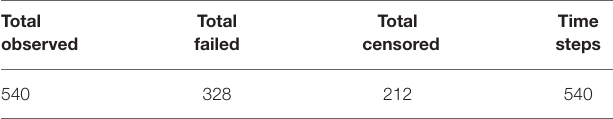
TABLE 6 | Summary statistics (events).